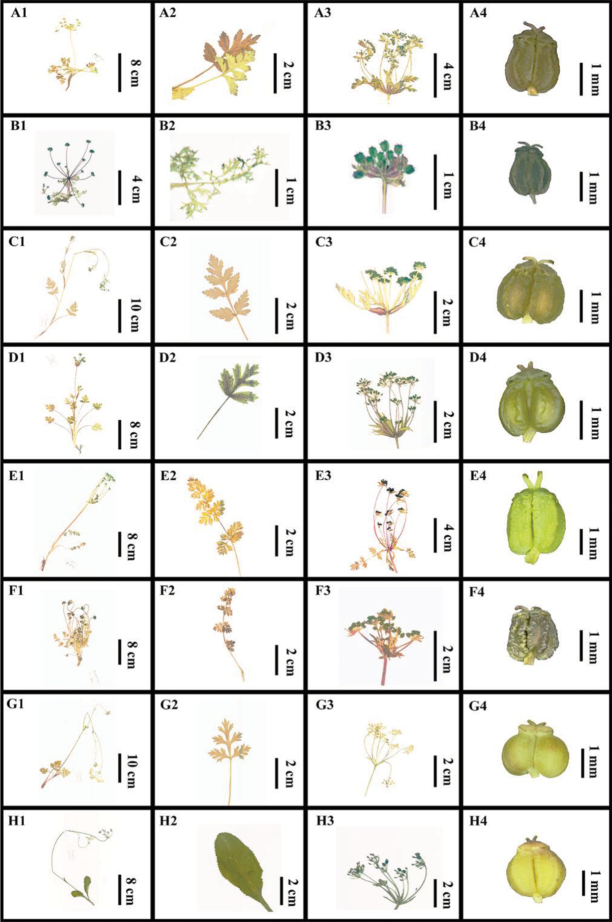
Morphological characters of PhysospermopsisA1–H1 habit A2–H2 basal leaf A3–H3 umbel A4–H4 mericarps A1 habit of P.
shanianaB1 habit of P.
nanaC1 habit of P.
muliensisD1 habit of P.
rubrinervisE1 habit of P.
obtusiusculaF1 habit of P.
kingdon-wardiiG1 habit of P.
delavayiH1 habit of P.
alepidioidesA2 basal leaf of P.
shanianaB2 basal leaf of P.
nanaC2 basal leaf of P.
muliensisD2 basal leaf of P.
rubrinervisE2 basal leaf of P.
obtusiusculaF2 basal leaf of P.
kingdon-wardiiG2 basal leaf of P.
delavayiH2 basal leaf of P.
alepidioidesA3 umbel of P.
shanianaB3 umbel of P.
nanaC3 umbel of P.
muliensisD3 umbel of P.
rubrinervisE3 umbel of P.
obtusiusculaF3 umbel of P.
kingdon-wardiiG3 umbel of P.
delavayiH3 umbel of P.
alepidioidesA4 mericarps of P.
shanianaB4 mericarps of P.
nanaC4 mericarps of P.
muliensisD4 mericarps of P.
rubrinervisE4 mericarps of P.
obtusiusculaF4 mericarps of P.
kingdon-wardiiG4 mericarps of P.
delavayiH4 mericarps of P.
alepidioides.